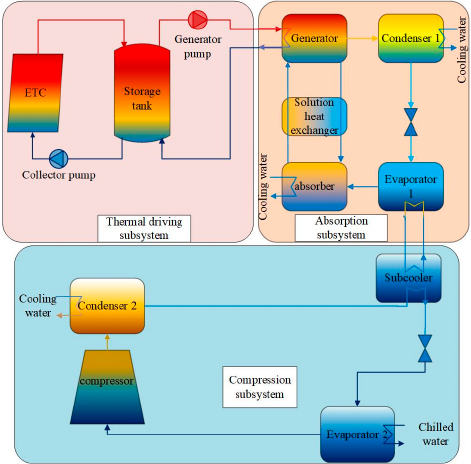
Figure 1. Schematic of solar absorption ‐ subcooled compression hybrid cooling system (SASCHCS).